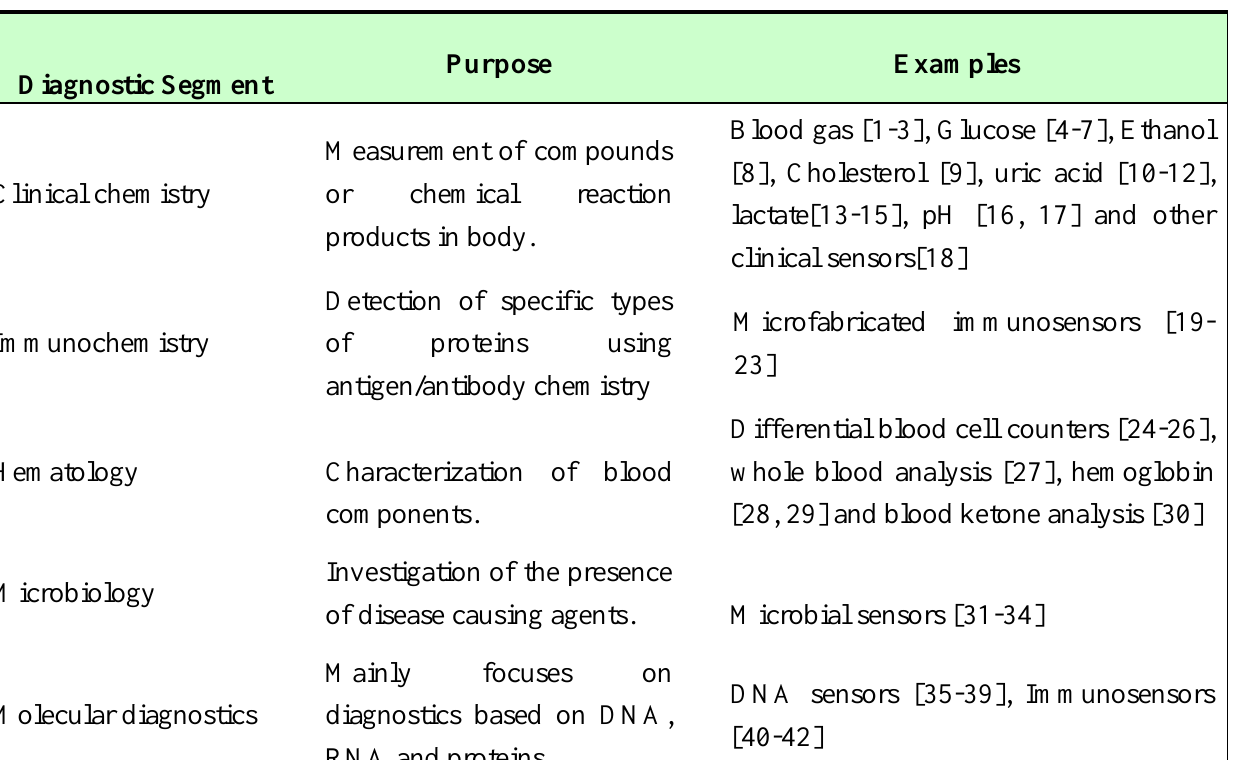
Table 1. Various segments of diagnostics and their MEMS based